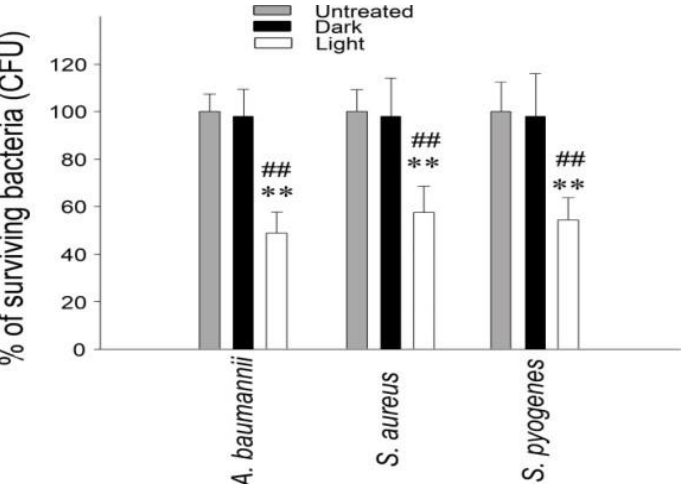
Figure 6. Visible-light - induced photolytic killing of pathogenic bacteria. The percentage of surviving bacteria without placement on the 484-nm TiO 2 (B) film (untreated groups) was normalized to 100%. n = 6, ## p < 0.01 (compared with the respective untreated group), ** p < 0.01 (compared with the respective dark group).